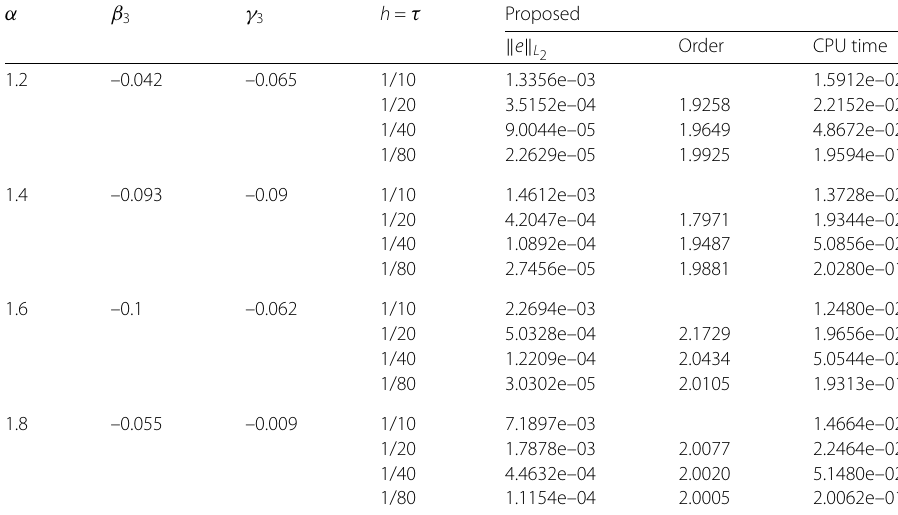
Table 5 Errors and corresponding observation orders at t = 1, λ = 1/50